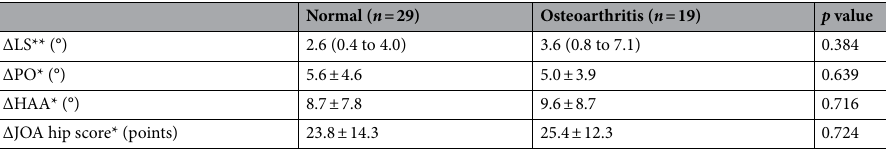
Table 4. A comparison of the absolute value of the change in coronal lumbar-pelvic-femoral alignment after conversion THA and of the change in the JOA hip score after conversion THA stratified by hip joint on the non-operative side. LS , lumbar scoliosis; PO , pelvic obliquity; HAA , hip adduction angle; JOA , Japanese Orthopaedic Association. ΔLS : the difference between the LS before and after surgery. ΔPO : the difference between the PO before and after surgery. ΔHAA : the difference between the HAA before and after surgery. ΔJOA hip score : difference between the JOA hip score before and after surgery. *Values are the mean ± standard deviation and were compared using Student’s t -test. **Values are the median (interquartile range) and were compared using the Mann–Whitney’s U test.